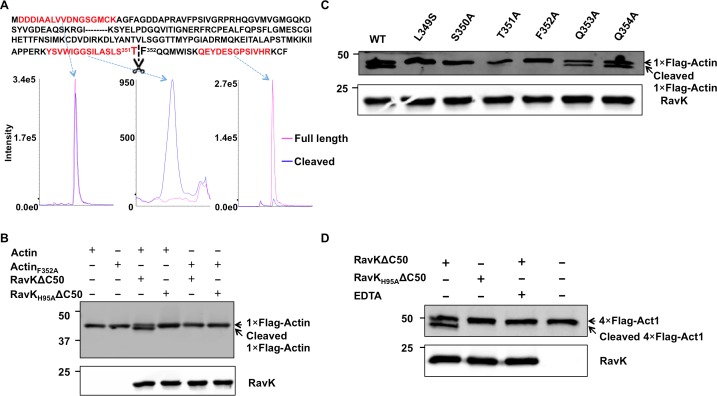
RavK cleaves β-actin by recognizing a site between T351 and F352.A. RavK cleaved β-actin at a site between T351 and F352. A portion of actin amino acid sequence containing the relevant peptides was shown. A comparison of the abundance of the semi-tryptic end peptide -YSVWIGGSILASLST- in two bands suggested that the cleavage site lies between T351 and F352. The abundance of two fragments located in the N-terminal and the C-terminal portion of actin, respectively, was compared to validate the results. B. The β-actin F352A mutant was resistant to RavK cleavage. HEK293T cells were transfected to express Flag tagged β-actin WT or its F352A mutant. 24 h after transfection, cell lysates were subjected to immunoprecipitation using M2 beads for 3 h. Proteins eluted with 3×Flag peptides were treated by either RavKΔC50 or RavKH95AΔC50 for 2 h and the samples were separated by SDS-PAGE and detected by immunoblotting with Flag-specific antibody. C. The Q353A and Q354A mutants of β-actin were still sensitive to RavK. Residues at the indicated positions were mutated and the mutant proteins were individually expressed in HEK293T cells, Flag-tagged proteins obtained as described in (B) were treated with RavKΔ50WT and were subjected to immunoblotting. D. The cleavage of yeast actin by RavK. Flag-tagged Act1 expressed in yeast obtained from cell lysates by immunoprecipitation was subjected to RavK cleavage. Samples were separated by SDS-PAGE and detected by immunoblotting with Flag-specific antibody and His6-specific antibody, respectively.